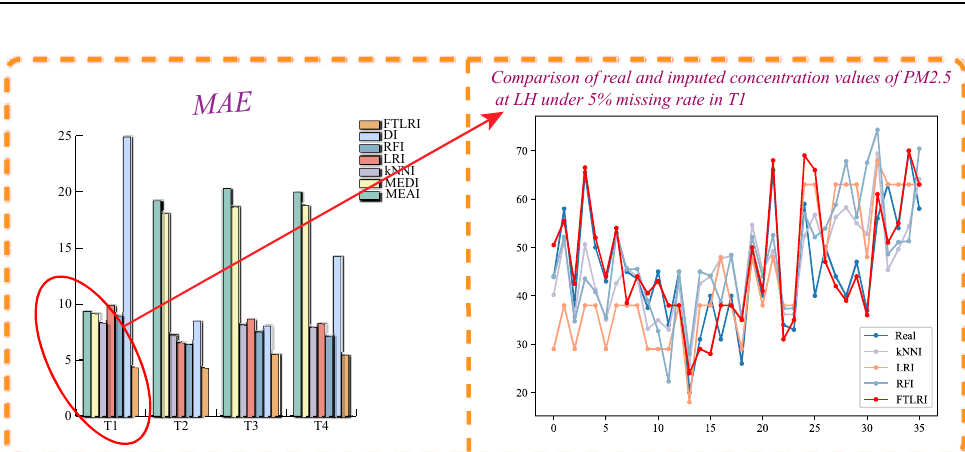
Comparison of real and imputed concentration values of PM2.5 at LH under 5% missing rate in T1